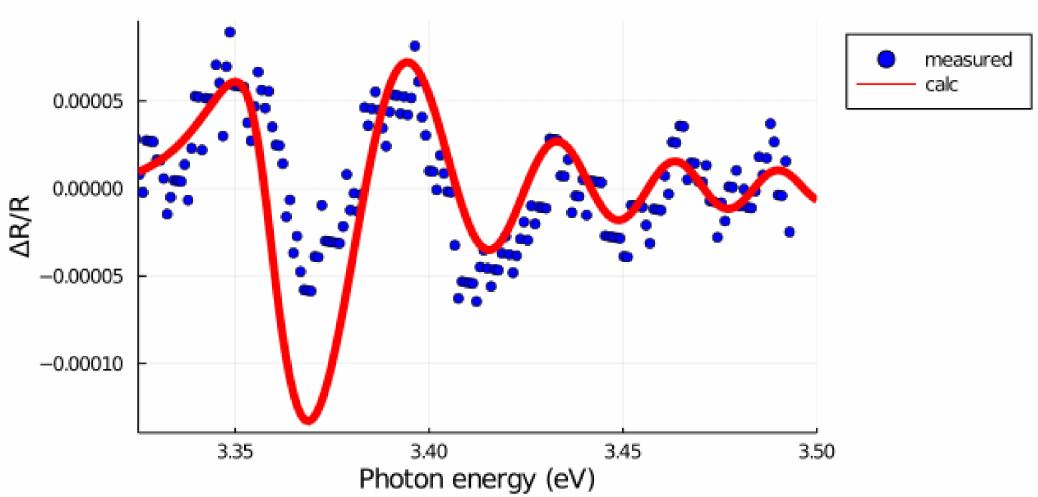
Figure 6. The photoreflectance spectrum of ZnO (closed circles) with using the VNDF. This spectrum is measured at 180 K. The solid line corresponds to a calculated result using Equation (2) of Ref.